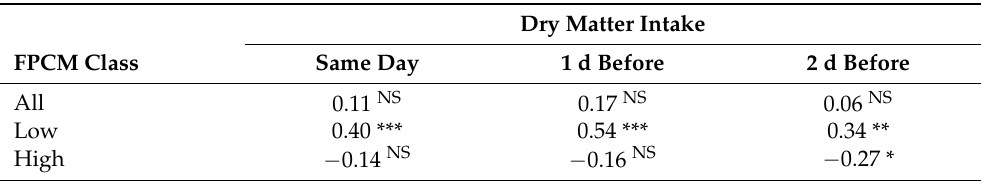
Table 2. Correlations between fat- and protein-corrected milk (FPCM) and dry matter intake measured either on the day of or one or two days before the milking event.